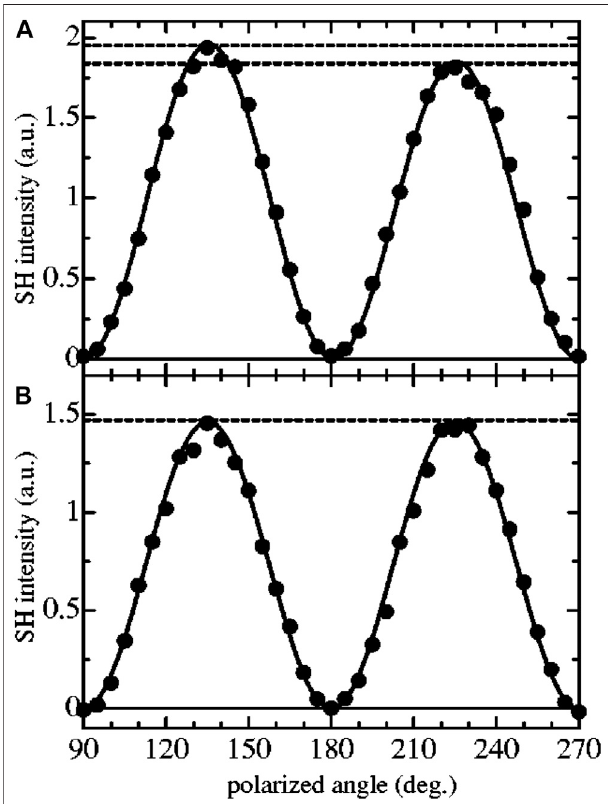
FIGURE 11 | Experimental results for the polarized angle dependence measurement for (A) 6OCB and (B) S -CCB monolayer. SHlightwasdetected for the transmitted direction. In this method, the analyzer angle was fi xed and the SH signals were measured as changing the input polarized angle. Solid circles represent the experimental results, and the solid line shows the fi tting curves using the appropriate formula I (2 ω ) The fi gureandcaptionhavebeenadaptedwithpermissionfromFujimakietal., (2003), Copyright © 2003 AIP Publishing.